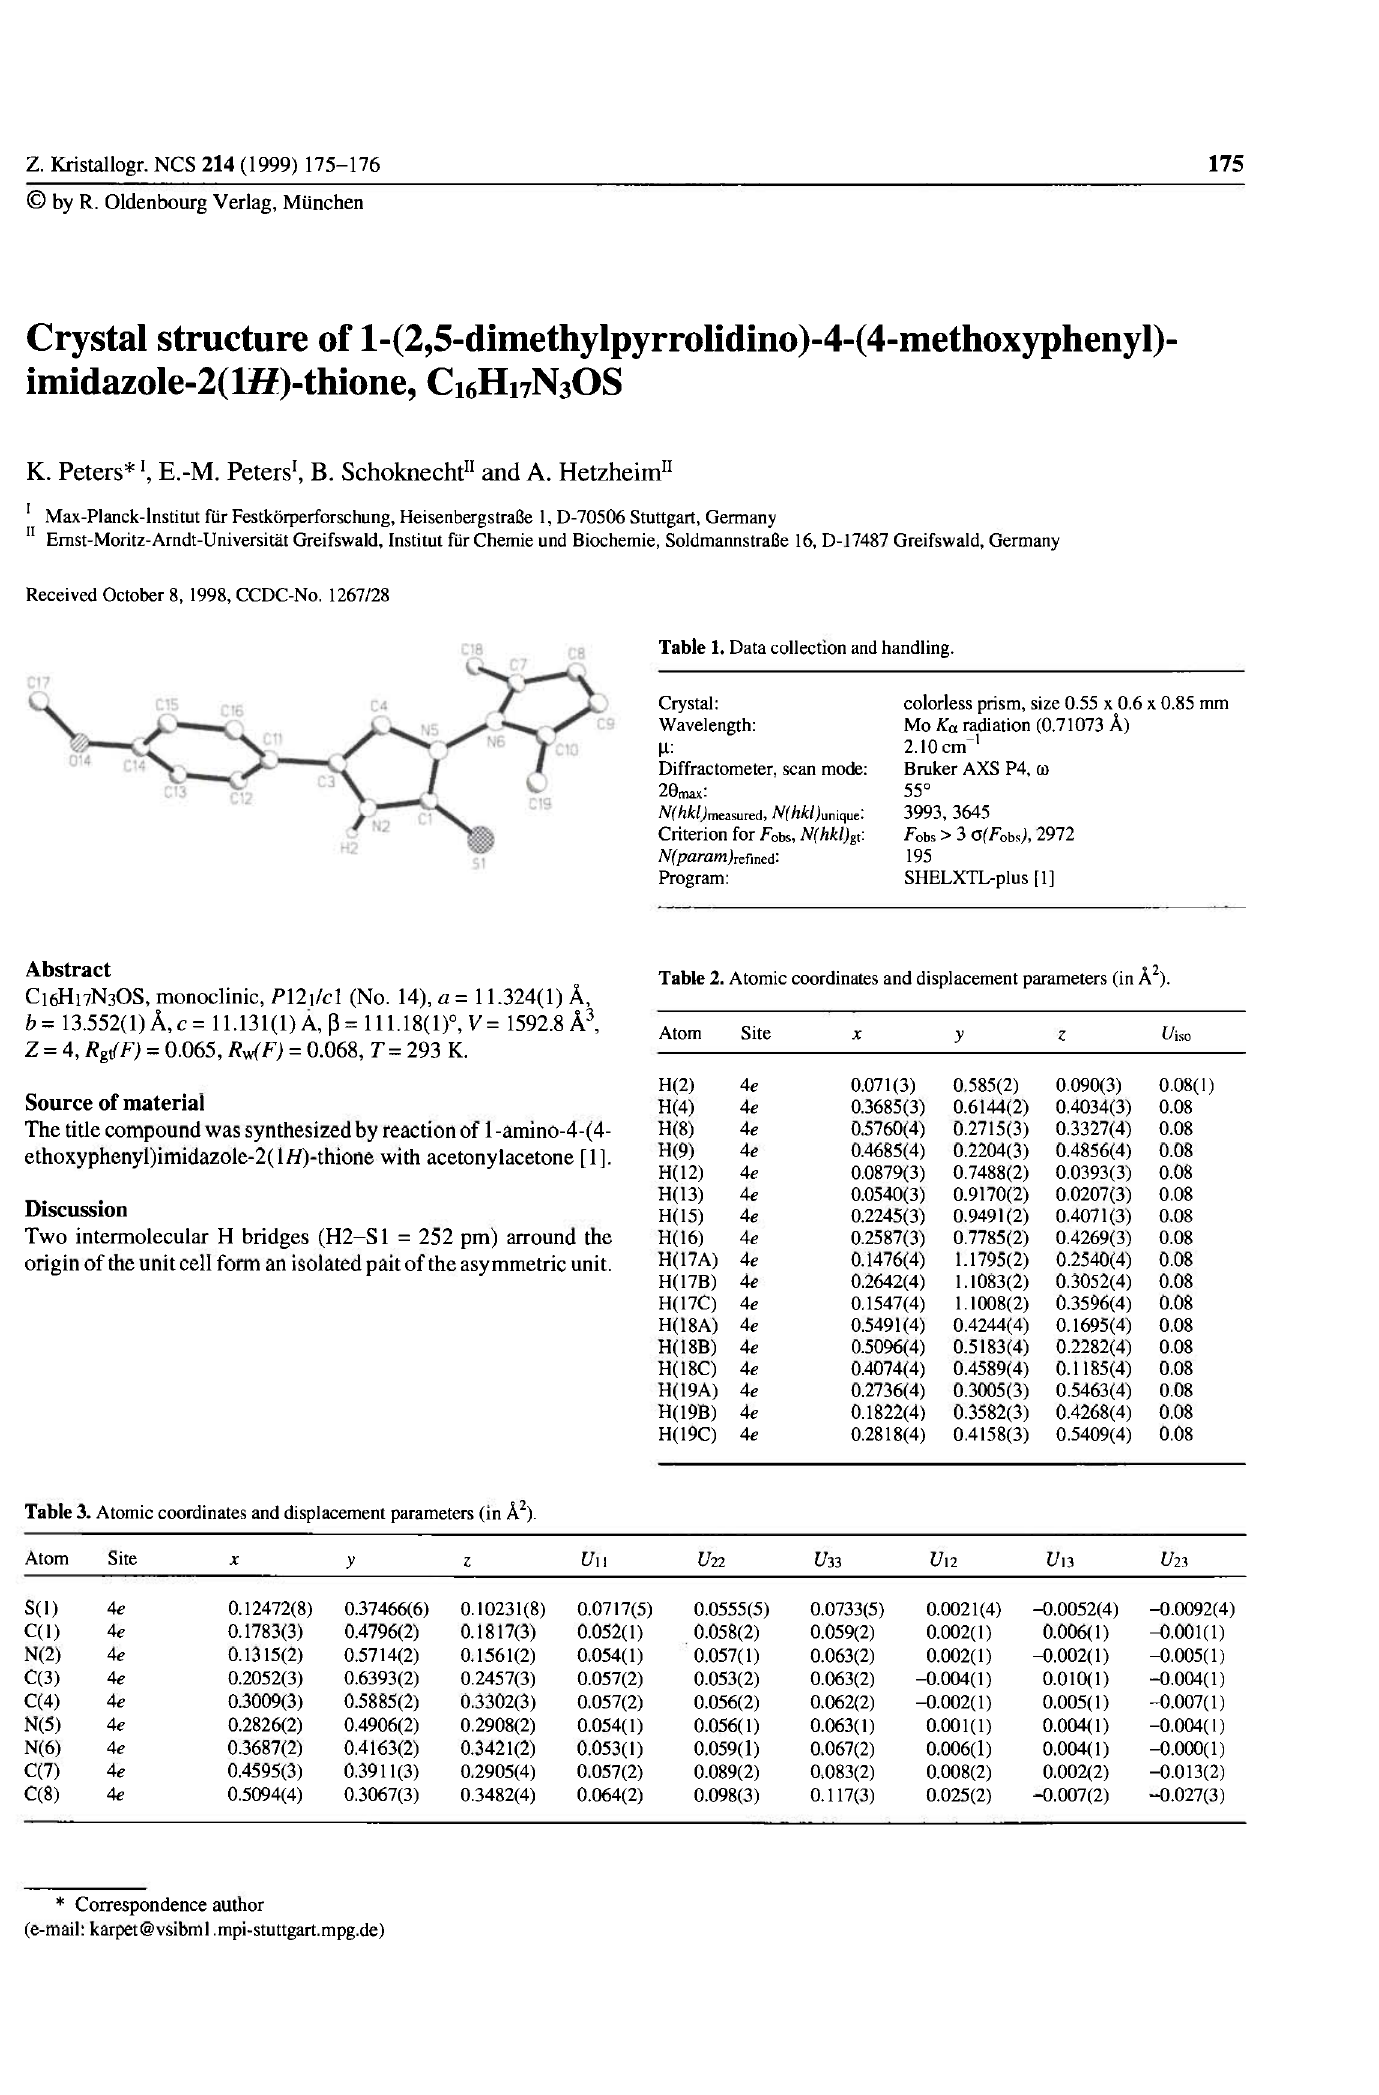
Table 2. Atomic coordinates and displacement parameters (in Ä 2 ).